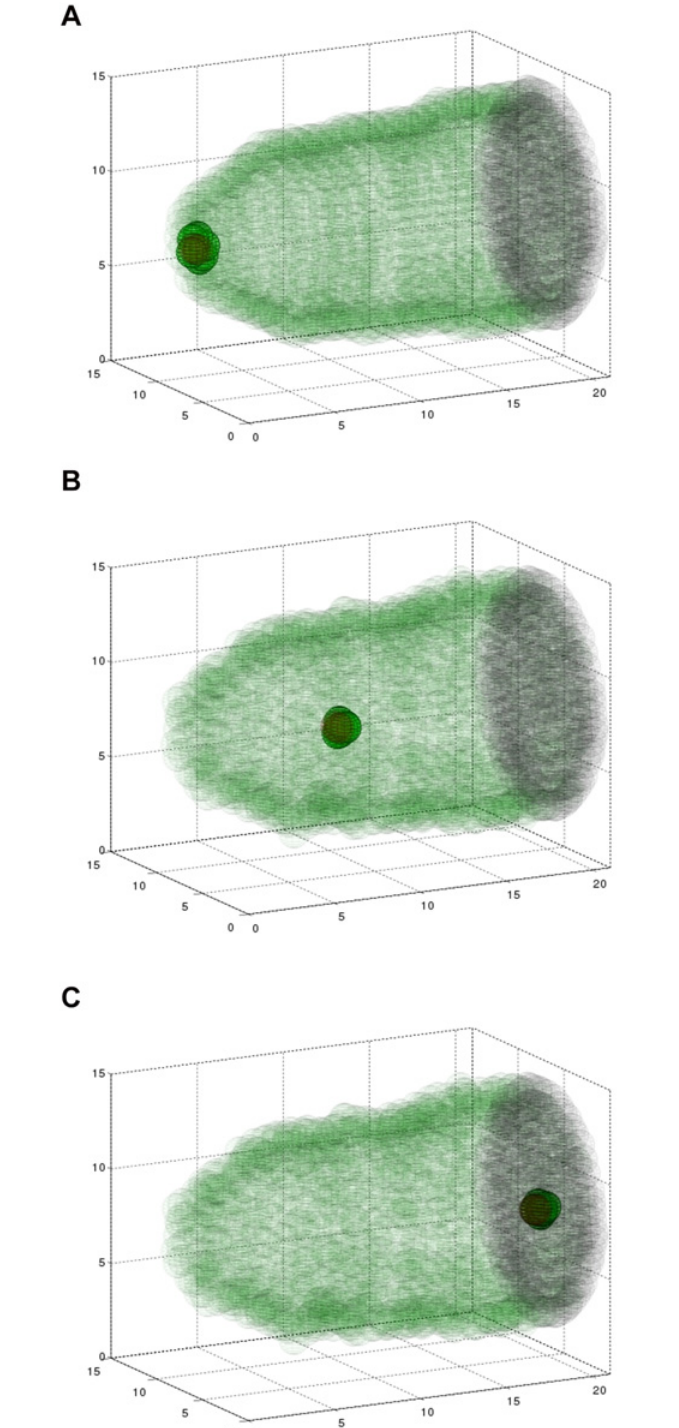
Fig 3. Simulating the three dimensional model results in collective migration. A simulation showing six border cells (green), two polar cells (red), the epithelium (transparent green), and the surface of the oocyte (black, right) at three time points during the migration. Fifteen nurse cells are situated inside the egg chamber, but are not plotted so as to maintain clarity of this three dimensional structure. Polar cells are surrounded by border cells, making them hard to distinguish. (A) At 2 minutes, cells are beginning to invade between